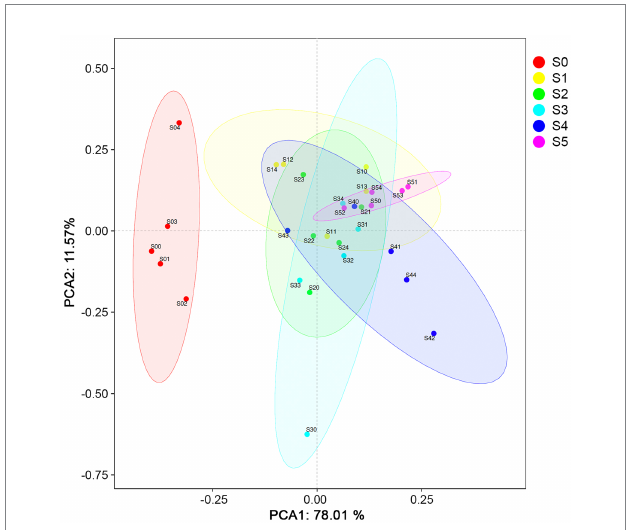
FIGURE 2 Principal component analysis (PCA) of the normalized soil elemental compositions and physicochemical